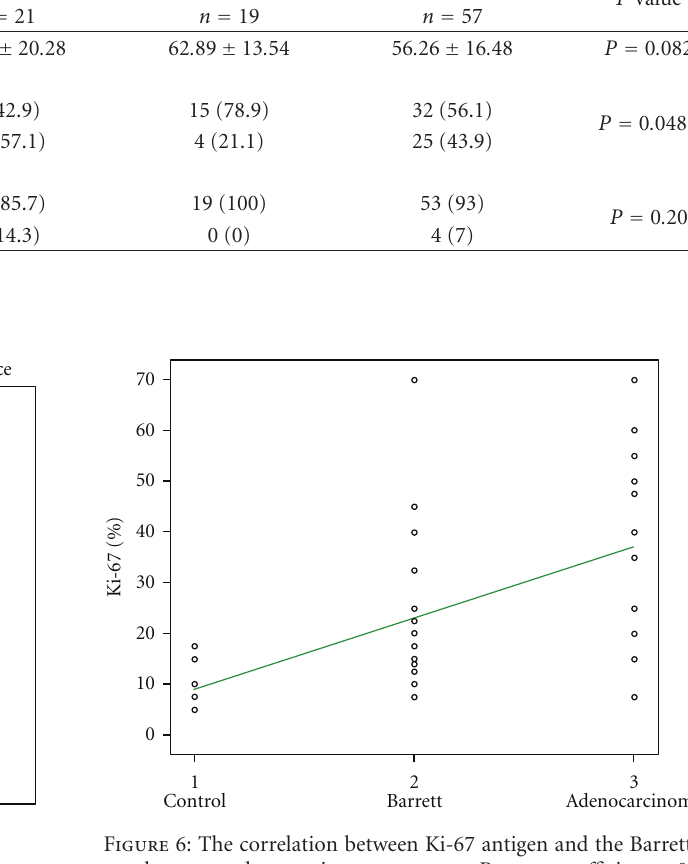
Figure 5: Ki-67 index variation between the three di ff erent groups (control, Barrett’s esophagus, and adenocarcinoma). There is increased expression of Ki-67 along the Barrett-adenocarcinoma sequence.